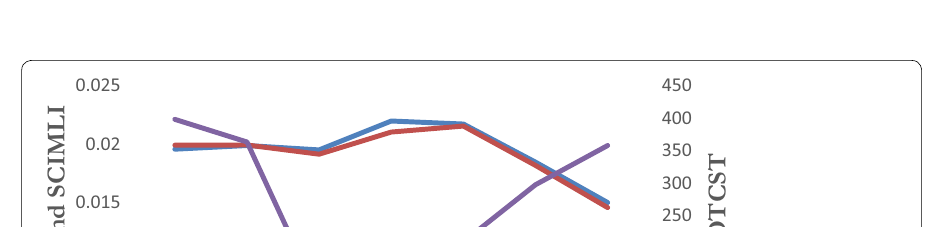
Fig. 1 Evolution of SCINAV and TCI (Source: Author)